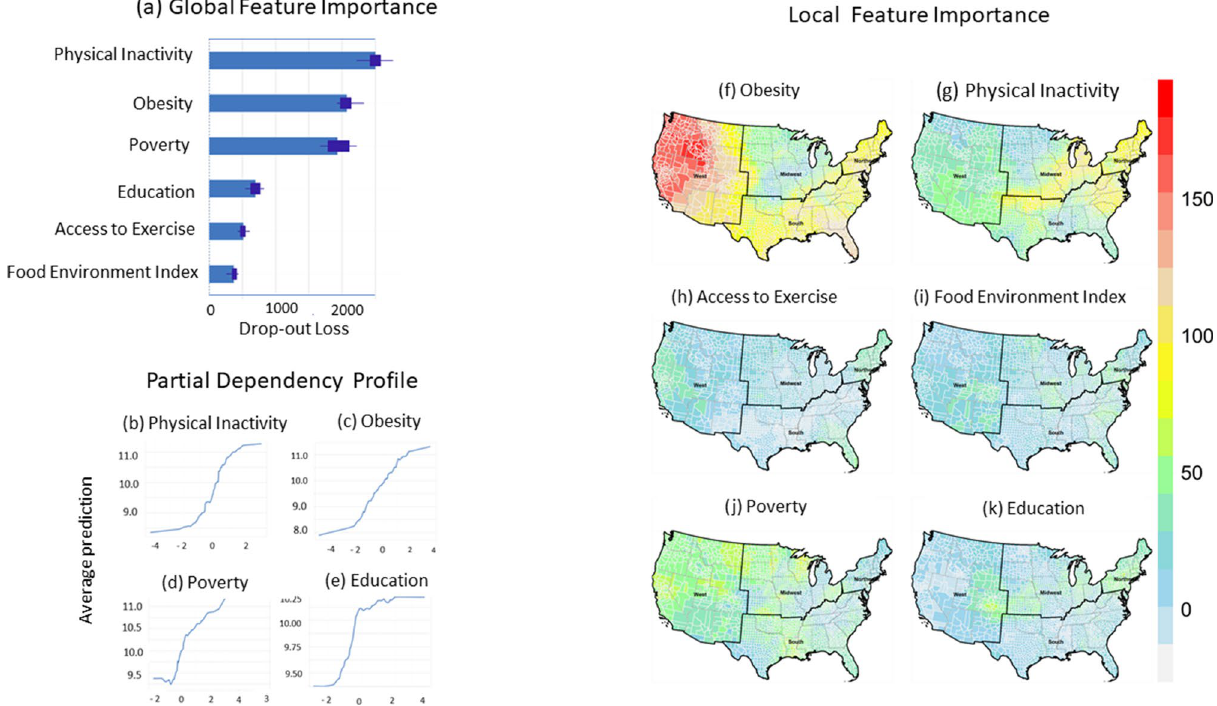
Figure 6. ( a ) Permutation-based feature importance from global random forest, ( b , c ) partial dependency profiles of the first four important variables of global random forest model, and ( f – l ) spatial variation of local feature importance (%incMSE) of obesity, physical inactivity, access to exercise, food environment index, poverty, and education in geographically weighted random forest regression models. Higher values imply increased importance. The random forest model was trained with 5 years of mean data (2013–2017) of 3108 counties. Maps were created in the R (version 4.0.0) Statistical Computing Environment 39 .